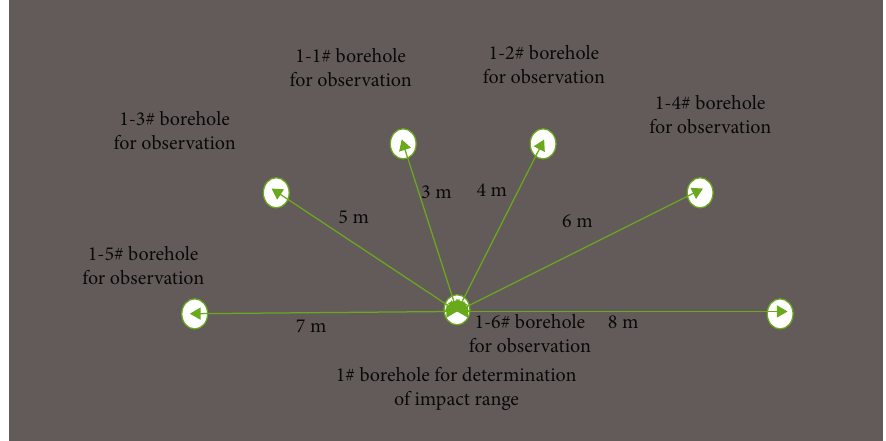
Figure 20: Borehole layout of hole group 1# in the in fl uence radius